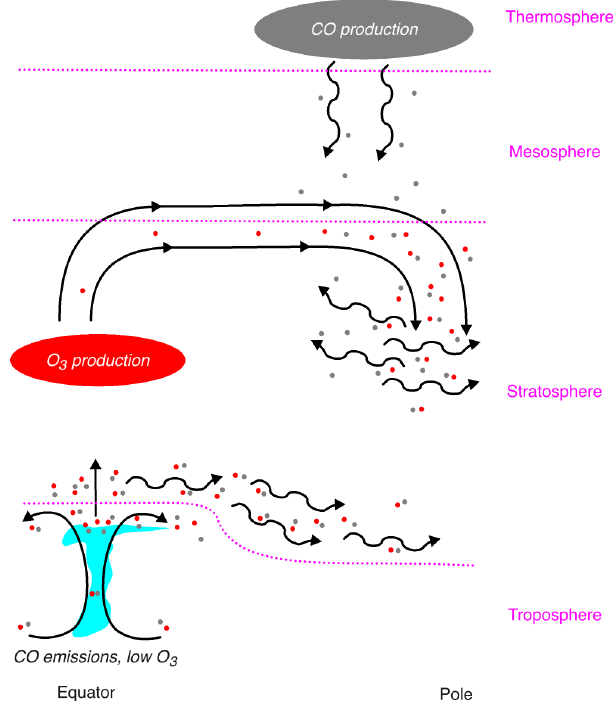
Figure 18. Schematic of transport errors produced by the speci- fied dynamics scheme. The residual circulation is illustrated by the steady black arrows, while the eddies are illustrated by the squiggly black arrows. Convection is shown by the light blue cloud, while photochemical production regions are shown by the large bubbles for (red) ozone and (gray) carbon monoxide, with the concentration indicating the severity of the error. Errors are shown by the small dots for (red) ozone and (gray) carbon monoxide. Dotted lines de- lineate the tropopause and stratopause.